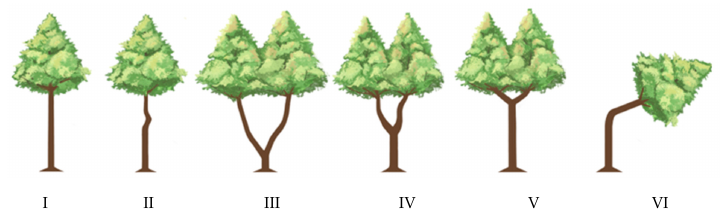
Figure 2. Classification criteria on stem form and silhouettes of tree stems.